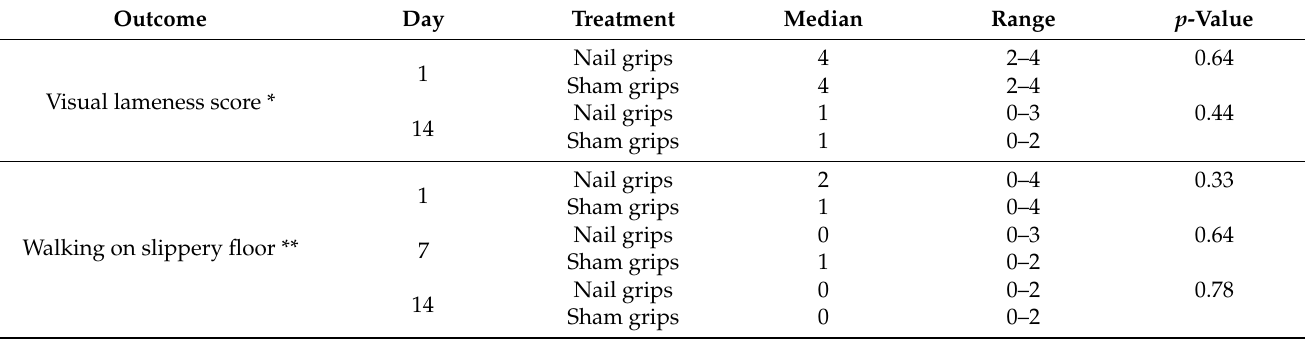
Table 3. Median and ranges of visual lameness scores and client-specific outcome measures for the nail grips group as compared to the sham